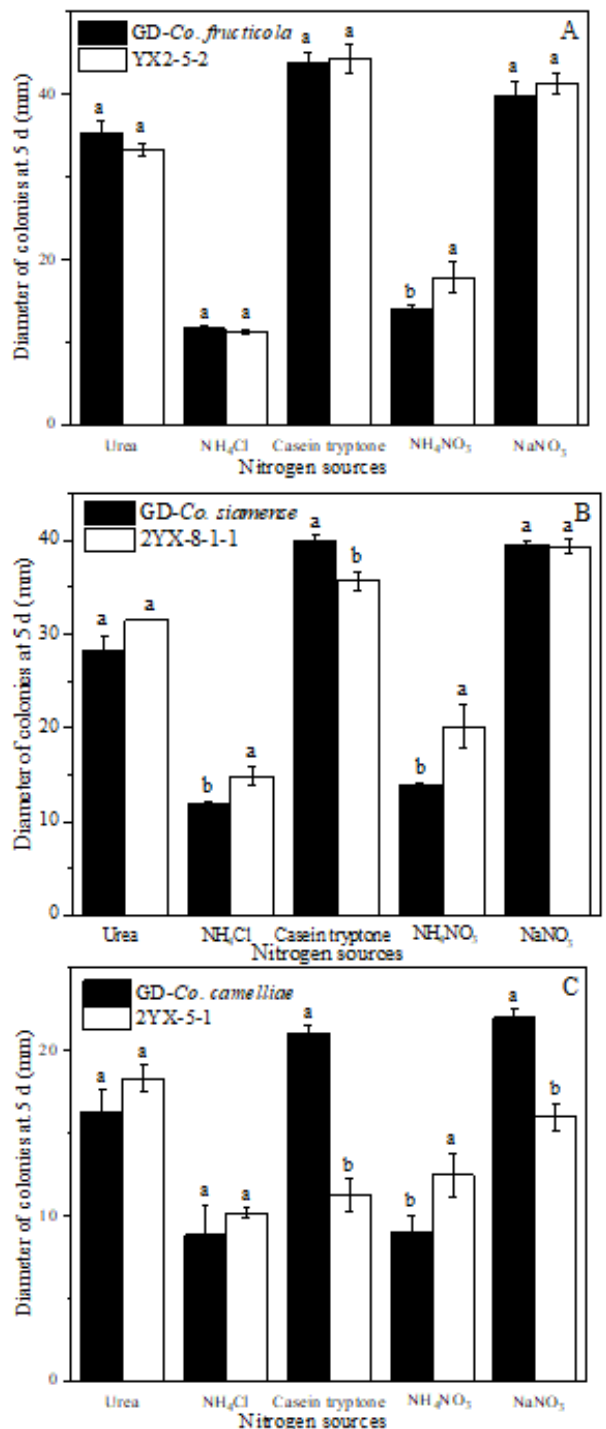
Figure 9. Effect of nitrogen sources on the growth of ( A ) YX- Co . fructicola (YX2-5-2) and GD- Co . fructicola ; ( B ) YX- Co . siamense (2YX-8-1-1) and GD- Co . siamense ; ( C ) YX- Co . camelliae (2YX-5-1) and GD- Co . camelliae . The error bars represent standard deviations based on three biological replicates. Diameters of colonies followed by the same lowercase letter are not significantly different at p < 0.05 using an ANOVA.